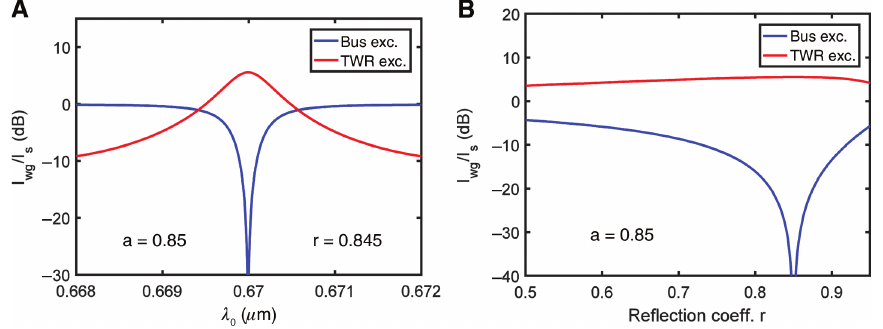
Figure 2: (A) Normalized electric field intensity coupled into the output waveguide (right port) in the case of bus-waveguide excitation and local excitation. The computation is performed at quasi critical coupling ( r  a ). For bus-waveguide excitation the resonance features a sharp dip whereas a broad peak is observed for the locally activated resonator. (B) Output waveguide coupled power resonance at 670.2 nm as a function of reflection coefficient r for a fixed attenuation value of a = 0.85. For both configurations, resonance occurs at critical coupling ( r = a